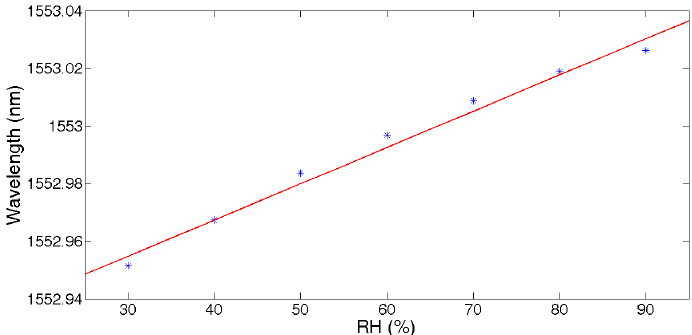
Figure 10. Central wavelength vs. humidity.